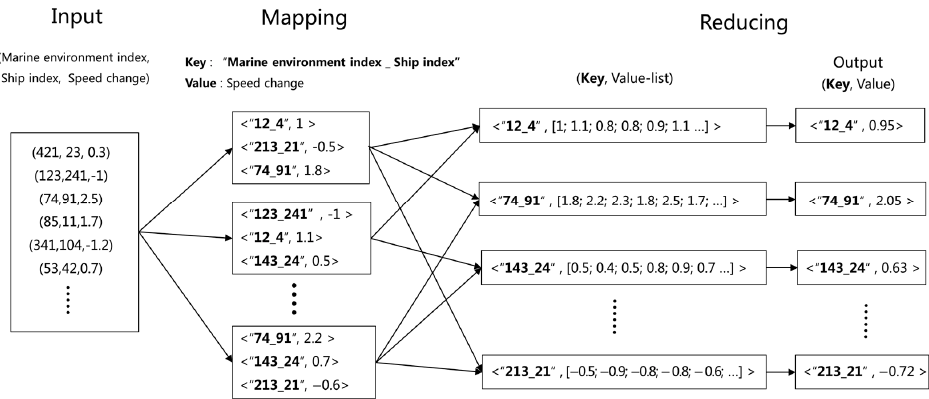
Figure 2. MapReduce operations for extracting externally forced speed changes.